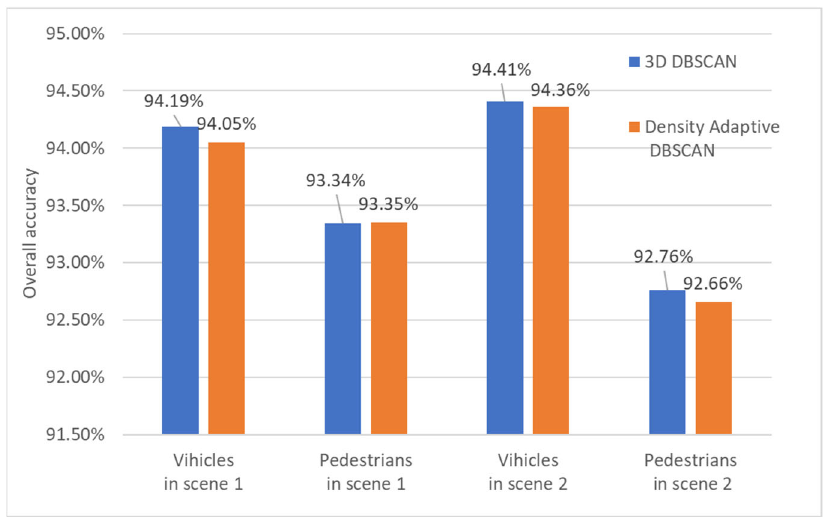
Figure 21. OA of 3D DBSCAN and density ‐ adaptive DBSCAN methods.